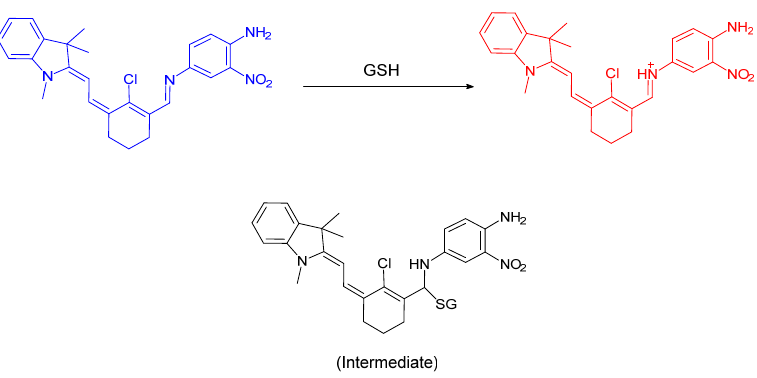
Figure 73. Structure of the GSH- selective probe HGc reported by Wang.